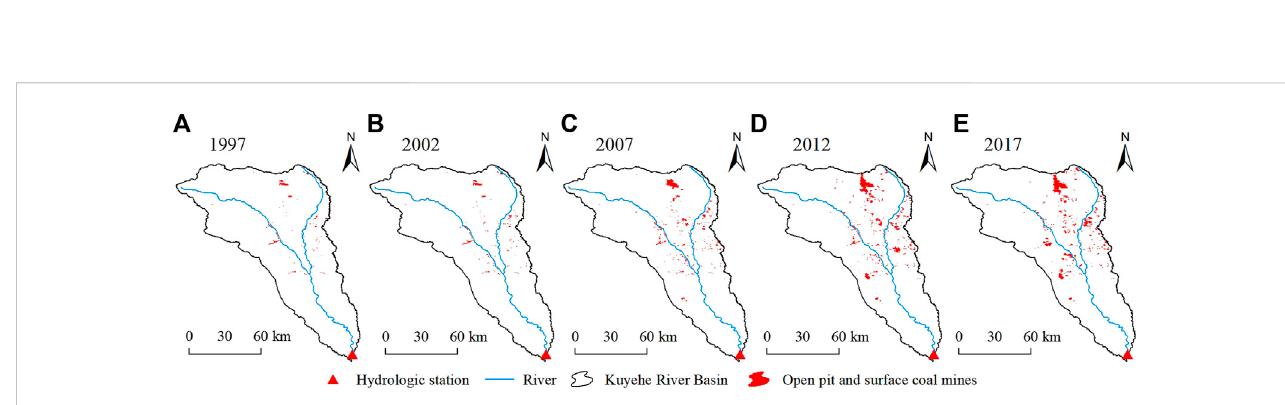
FIGURE 7 Coal mining situation in KRB in 1997, 2002, 2007, 2012, and 2017. (A) 1997, (B) 2002, (C) 2007, (D) 2012, (E) 2017.